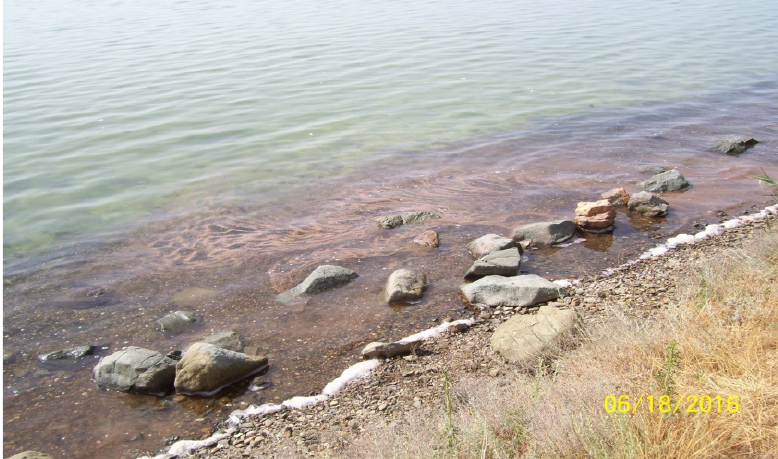
Figure 5. Artemia cysts on the shore of Eastern basin of Saki Lake.